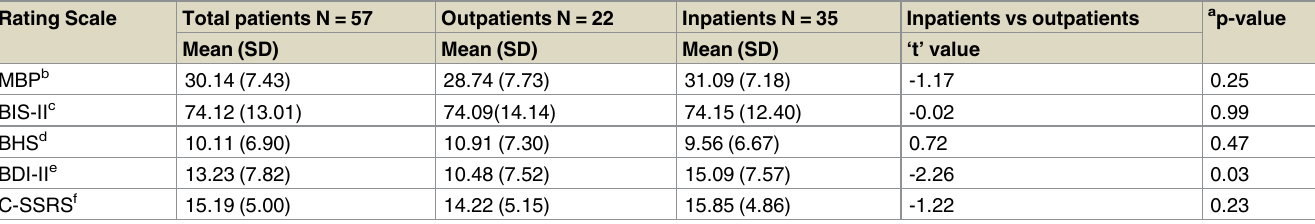
Table 2. Comparison of test scores of in- versus outpatients a . Rating